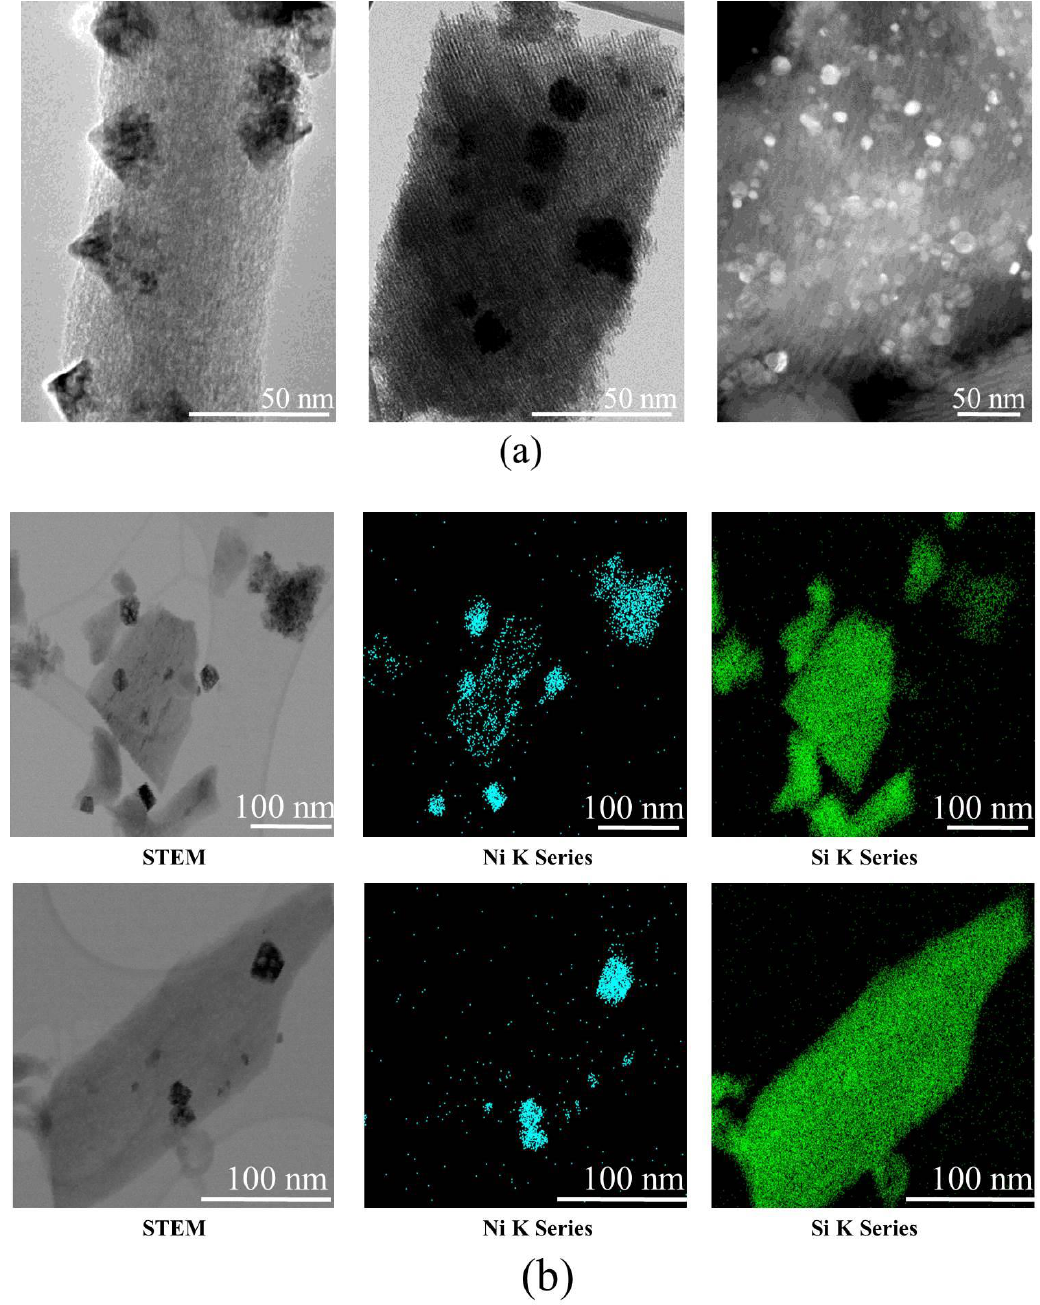
Figure 10. ( a ) HRTEM image and ( b ) HAADF-STEM images and corresponding EDS elemental mapping images of Ni/MCM-41.